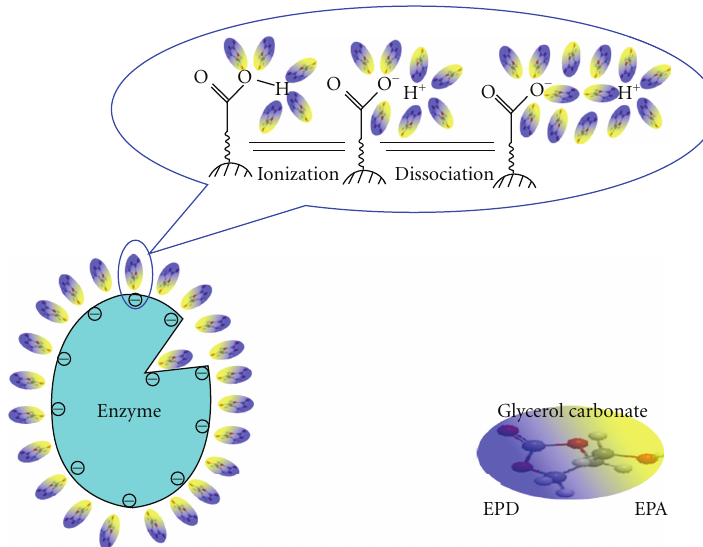
Figure 1: Ionization and dissociation processes of an enzyme in GC.